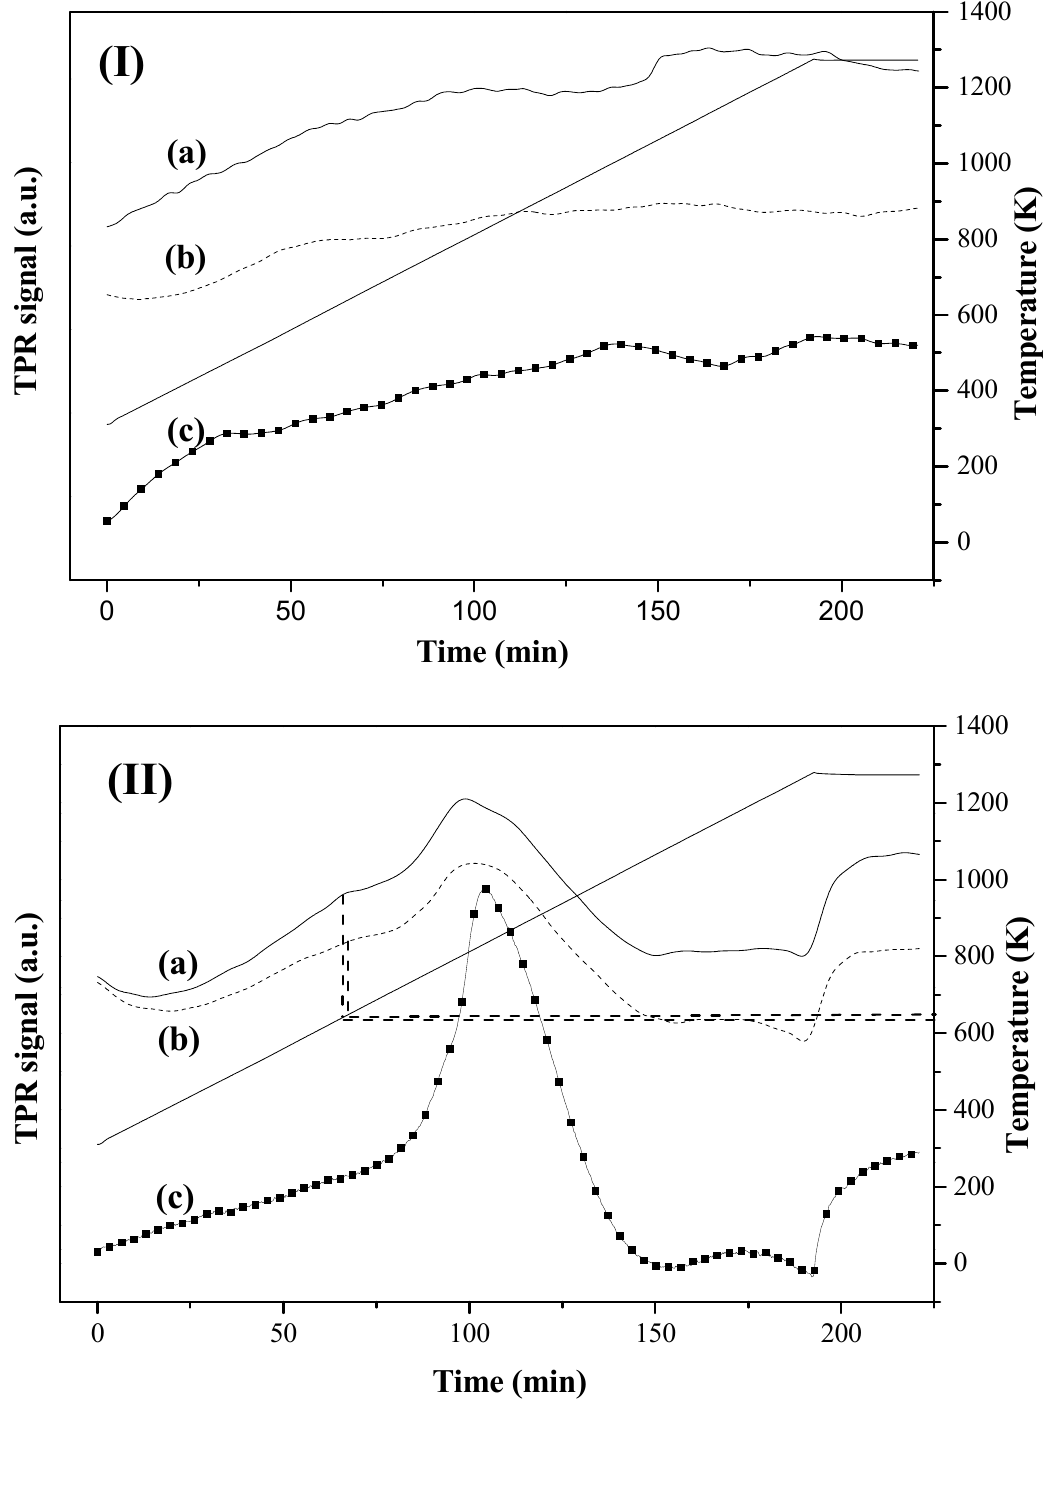
Figure 4. TPR profiles associated to samples ( I ) Au/G and ( II ) Au/CNF-F, synthesized by the methods ( a ) -IMP, ( b ) -SGT and ( c ) the corresponding